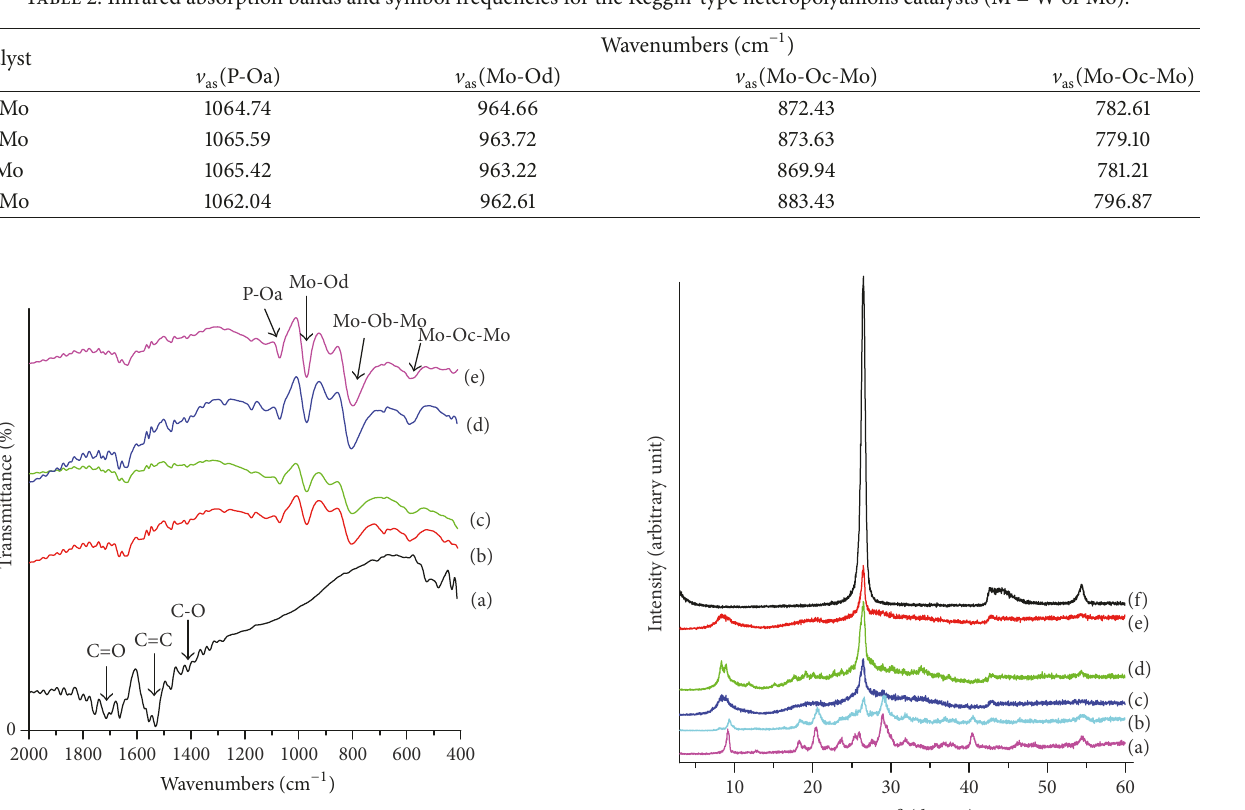
Table 2: Infrared absorption bands and symbol frequencies for the Keggin-type heteropolyanions catalysts (M = W or Mo).